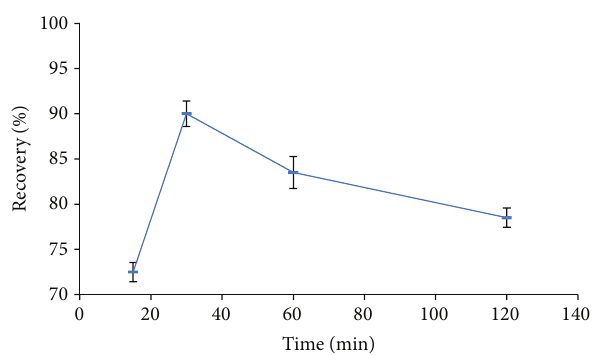
Figure 5: AFM1 HPLC-FLD chromatograms for 0.5 𝜇 g/kg standard (A) and 0.05 𝜇 g/kg egg spiked sample